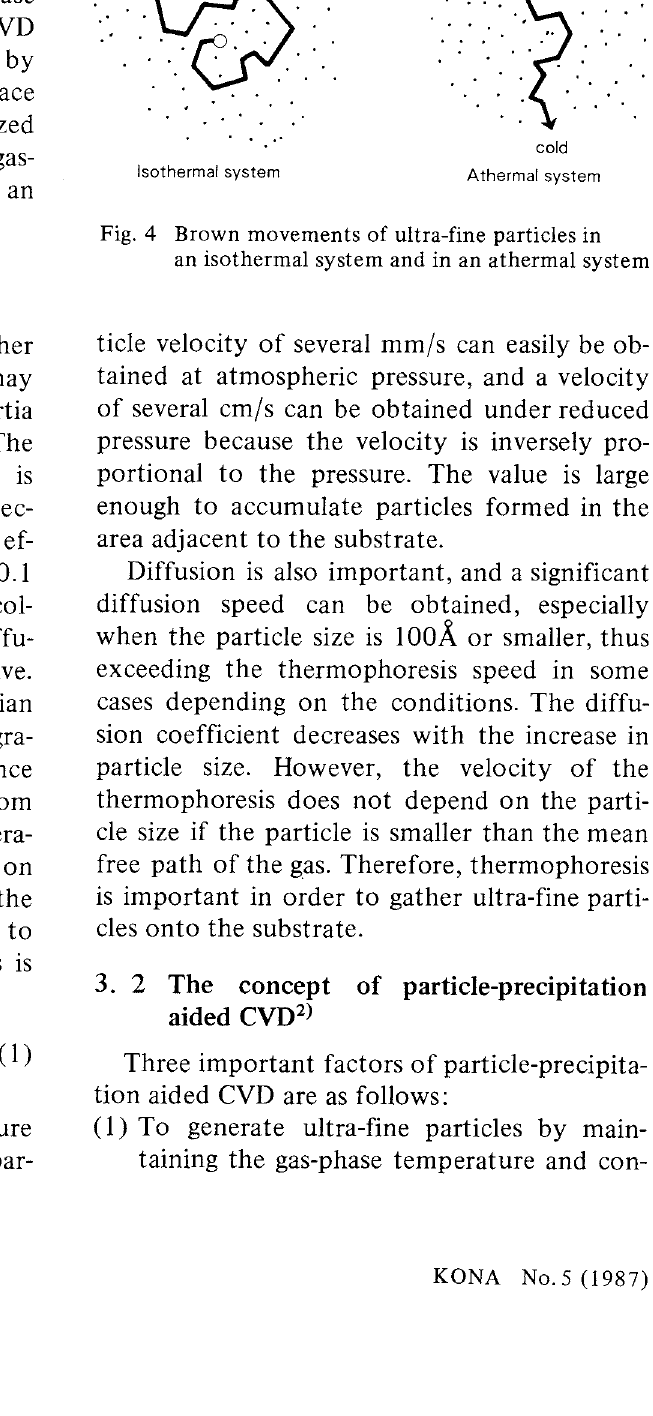
Fig. 3 A schematic drawing explaining the particle formation mechanism in tubular reaction equipment (for titania synthesis 7 ))